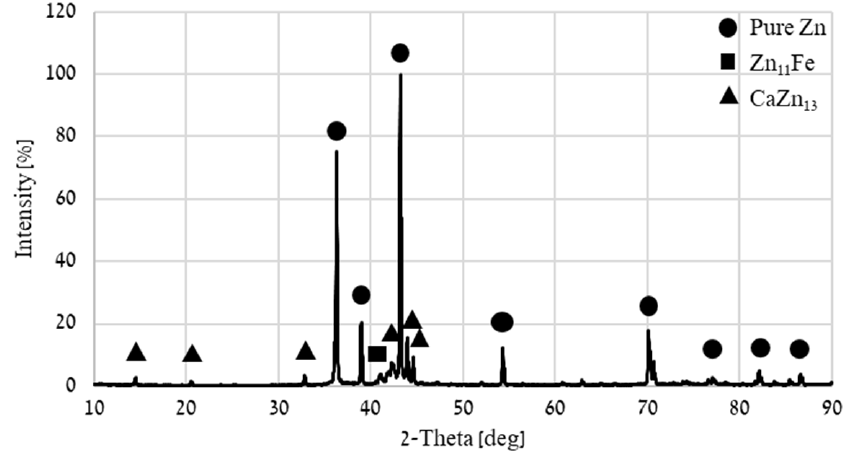
Figure 1. XRD diffraction analysis of Zn-2%Fe-0.6%Ca alloy. Figure 2 and Table 1 show the typical microstructure obtained by SEM and EDS analysis results. The microstructure of the ternary alloy contains the Fe-rich phase (Zn 11 Fe) and Ca-rich phase (CaZn 13 ) in addition to the pure Zn matrix, as also shown in the previous article of the author [25]. In this composition, the Ca-rich phase is present in the form of a three-petaled